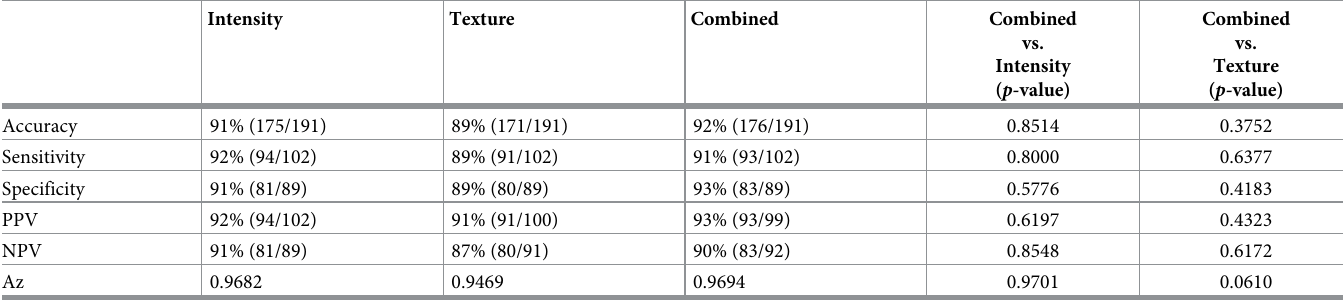
Table 3. The performance comparisons of intensity features, texture features, and the combination of both feature